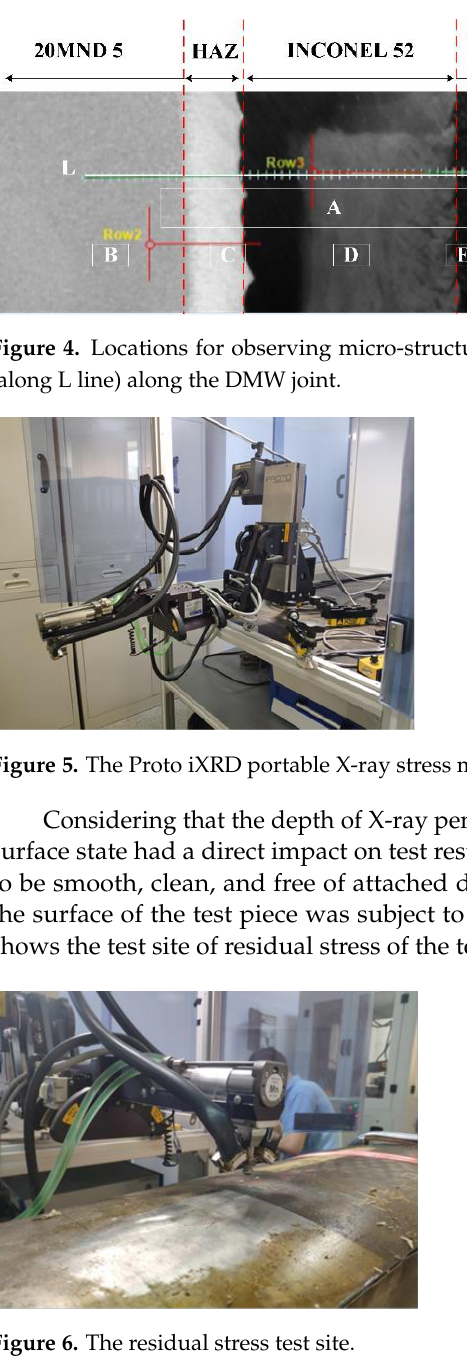
Figure 4. Locations for observing micro-structures (from A to F ) and measuring micro-hardness (along L line) along the DMW joint.